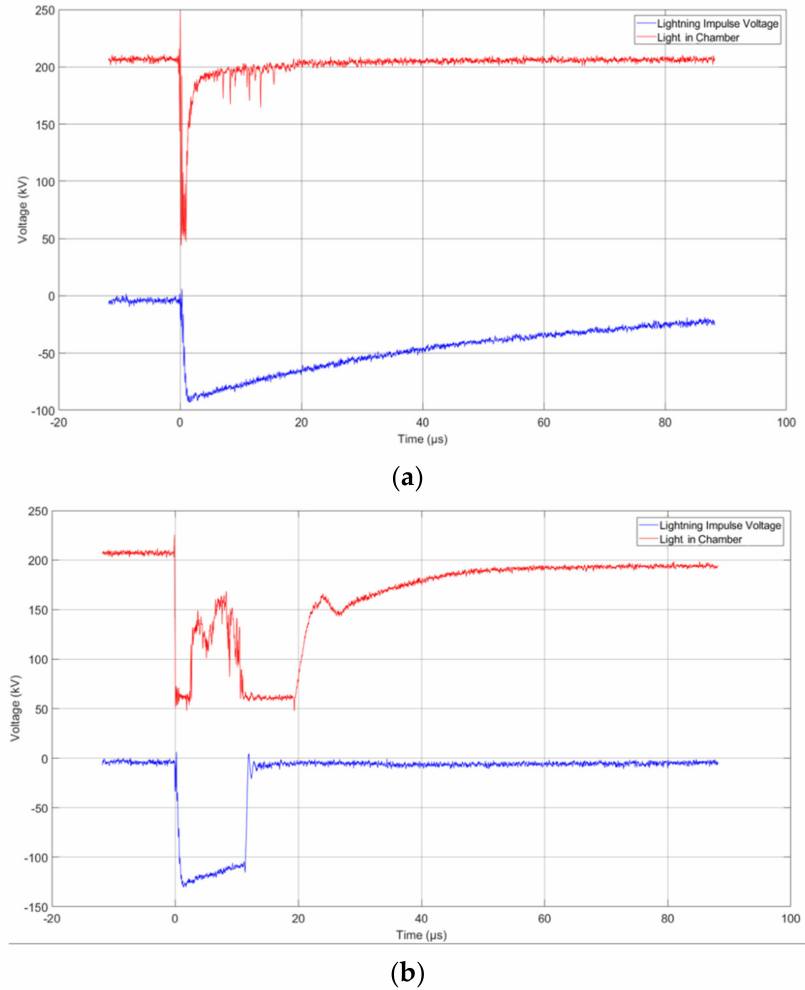
Figure 14. Examples of voltage and light waveforms collected during LI tests in mineral oil: ( a ) without breakdown, ( b ) when breakdown